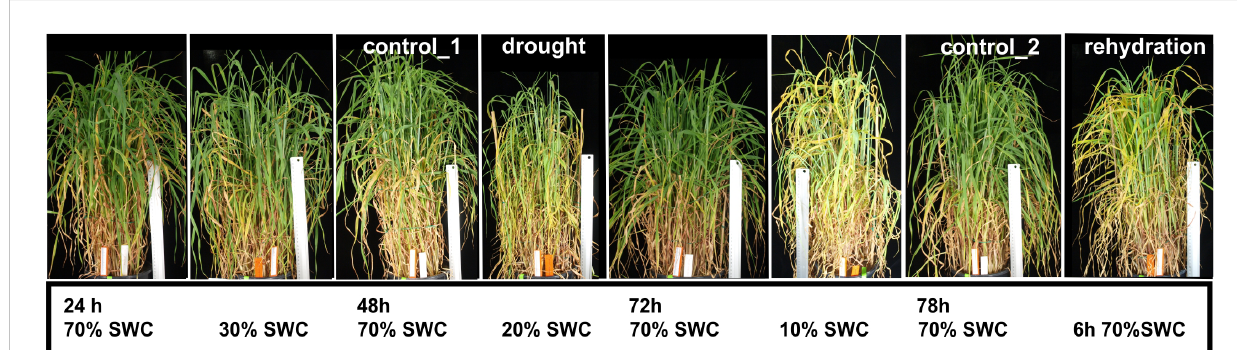
FIGURE 1 Barley ( Hordeum vulgare , genotype Rolap) plants ’ appearance during the course of a drought and rehydration stress experiment. Drought stress was applied by withholding watering, after 48 h, when soil water content (SWC) dropped to 20%, plants were collected and treated as drought-stressed. Next day, when SWC reached 10%, plants were watered, collected 6 h later and treated as rehydrated. Control_1 (C1) and control_2 (C2) plants were collected for drought (D)- and rehydration (R)-treated samples,